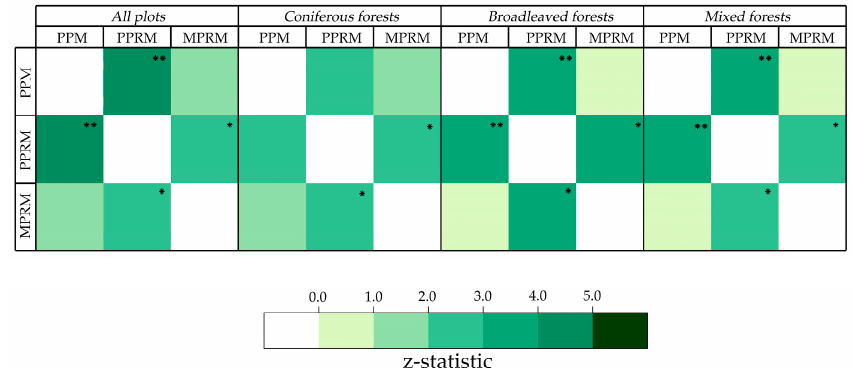
Figure 7. The statistical values of the Wilcoxon rank sum test ( α = 0.05) for the Packalén error index e P values from the reference and predicted volume distributions using LiDAR-predicted stem density N LiDAR as the scaling variable by the PPM, PPRM, and MPRM. PPM: parameter prediction method; PPRM: percentile-based parameter recovery method; MPRM: moment-based parameter recovery method; significance level: * p < 0.05; ** p < 0.01.